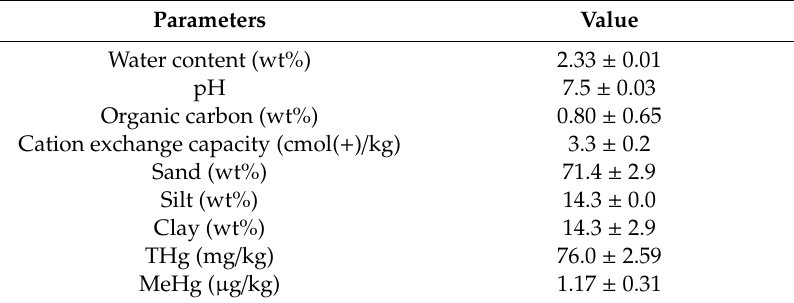
Table 2. The physicochemical properties of An-Shun site